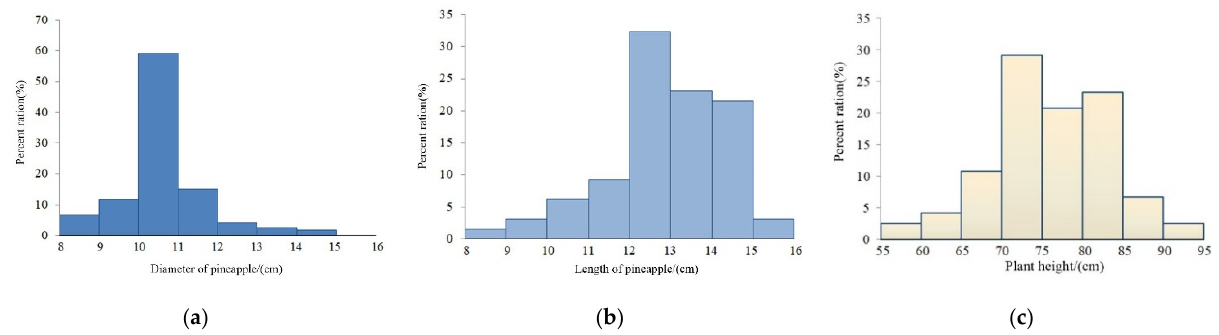
Figure 2. Histogram of statistical data. ( a ) Diameter of pineapple. ( b ) Length of pineapple. ( c ) Height of plant.